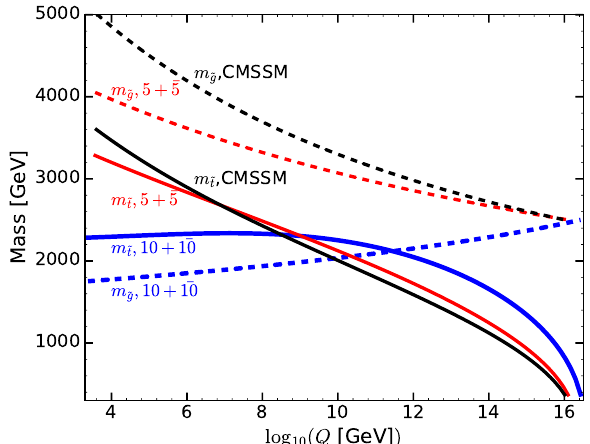
Figure 1. The dashed lines show the running of the gluino soft mass, M 3 (black), the LD model (red), and the QUE model (blue). The running of the right-chiral stop soft mass, m ~ , is plotted with solid lines in the same color code. We have considered m 1 = 2 = t 2 : 5 TeV ; m 0 = 600 GeV and A 0 = 2 : 5 TeV in all cases and set the VL Yukawa couplings to zero. Note that the GUT scale in the LD and QUE models is slightly lower than in the